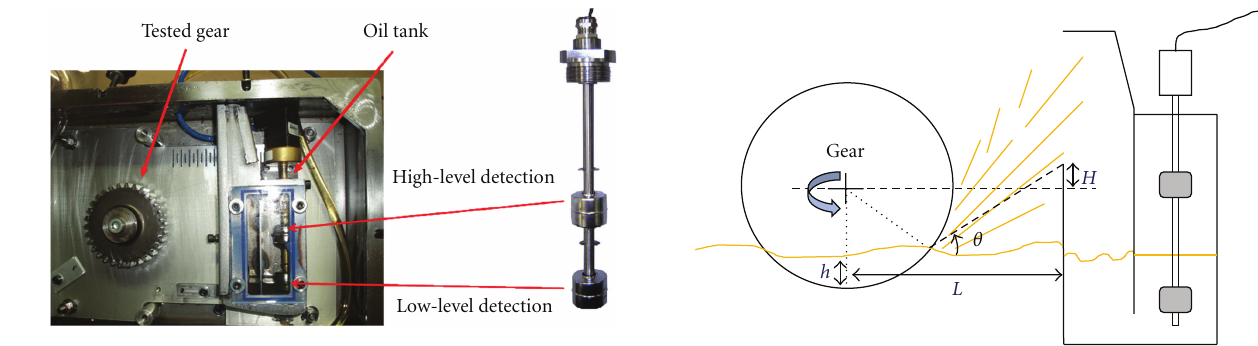
Figure 1: Oil tank in churning test rig.